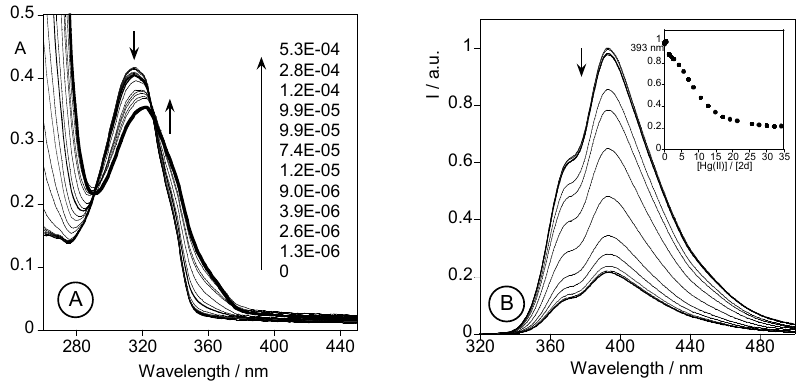
Figure 5. Spectrophotometric titration (A) and fluorimetric titration (B) of an ethanolic solution of 2d with a standard solution of Hg(CF